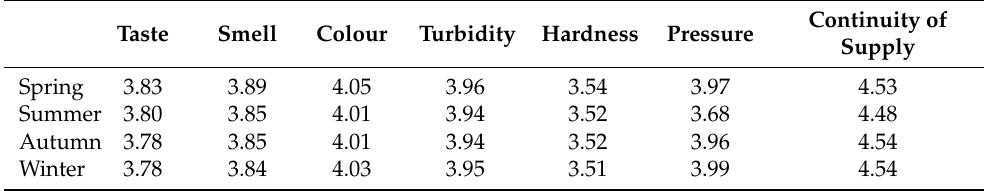
Table 4. Average ratings for tap water parameters by